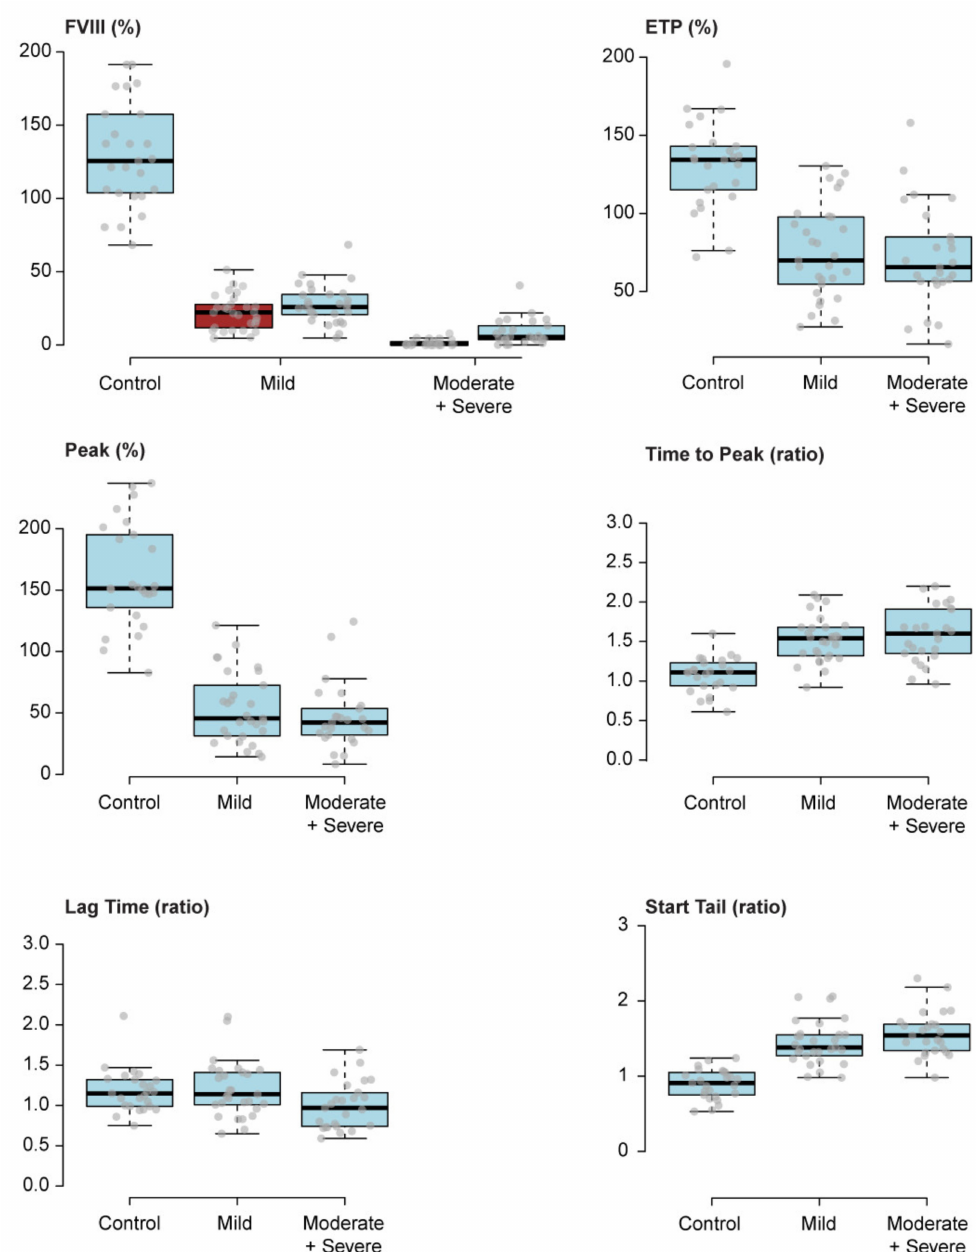
Figure 3. Box plots depicting TGT parameters and FVIII activity at the time of TGT. FVIII activity measured at the time of TGT and at the time of diagnosis (matched assay) in brown (upper left graph). In the other graphs, Endogenous Thrombin Potential (ETP); Peak; Time to Peak; Lag Time and Start Tail are